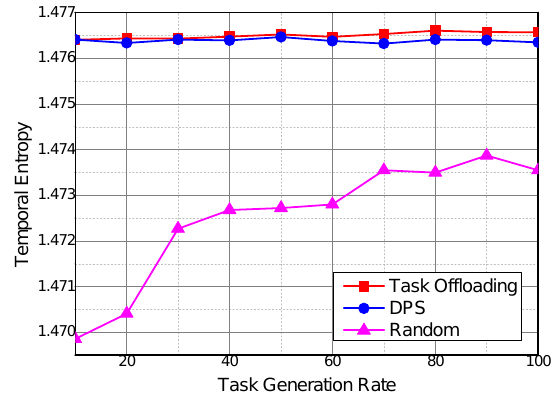
Figure 15. Temporal entropy under different task generation